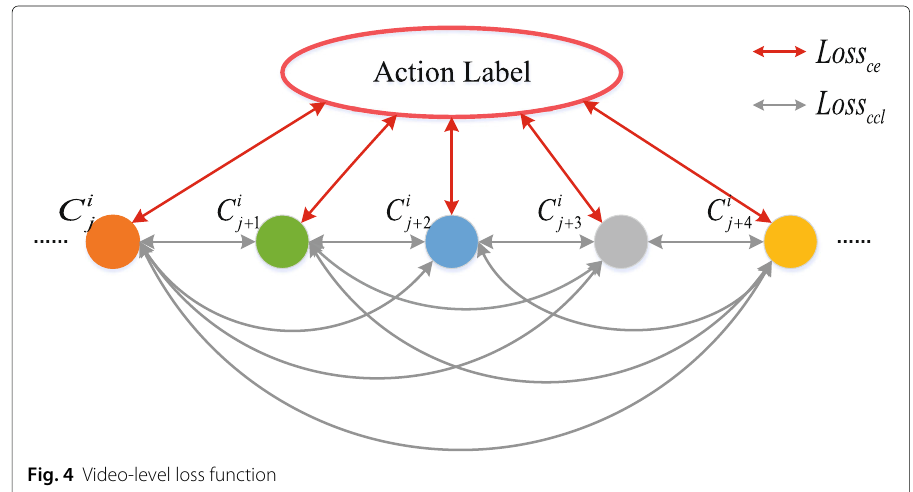
Fig. 4 Video-level loss